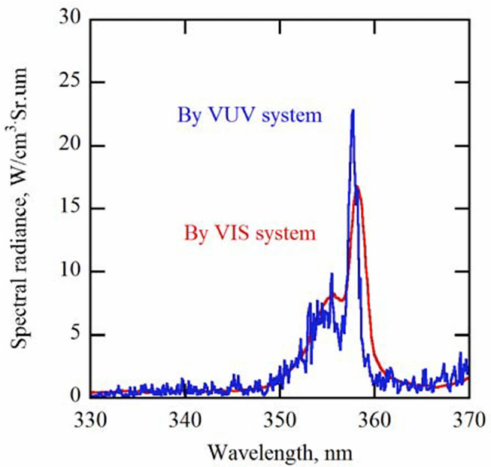
Figure 32. Comparison of the measured CN violet bands in UV region obtained using VUV and VIS spectrometers (from